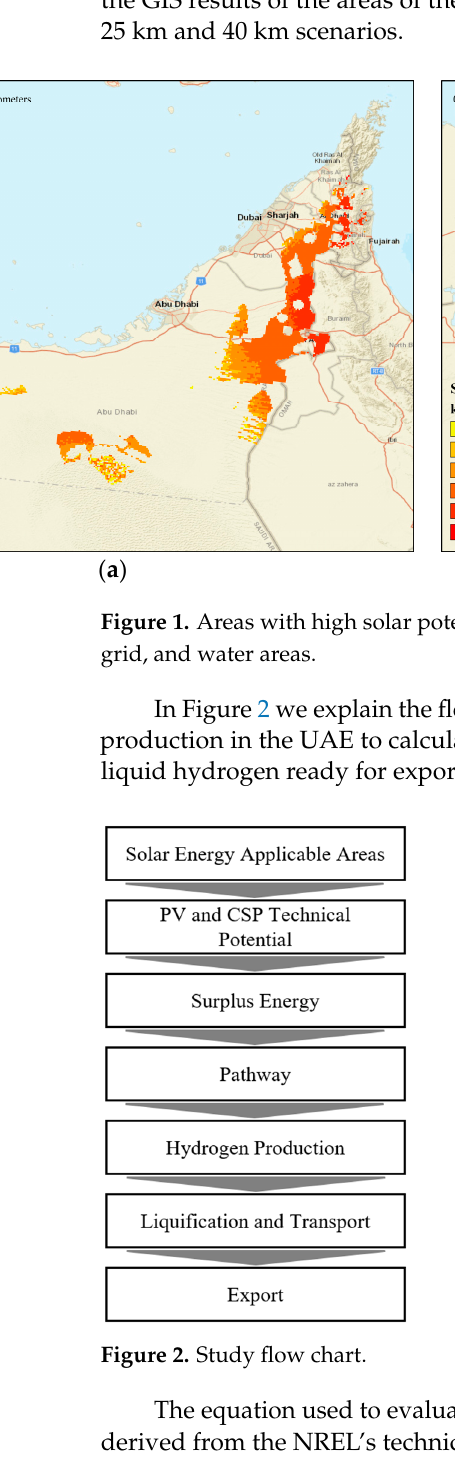
Figure 3. Pathways’ layout. The network analyst function of GIS is used to carry out the spatial analysis after uploading the road network of the UAE and specifying the use of only main roads and highways where hydrogen trailers are allowed to drive. Similarly, the data of the UAE’s electric grid are inserted, and lines with 220 voltage and above are chosen for the analysis. Then, the six plants and chosen ports are fixed on the map. Finding the closest facility tool is then used to estimate the shortest routes between each plant and each port for both pathways.